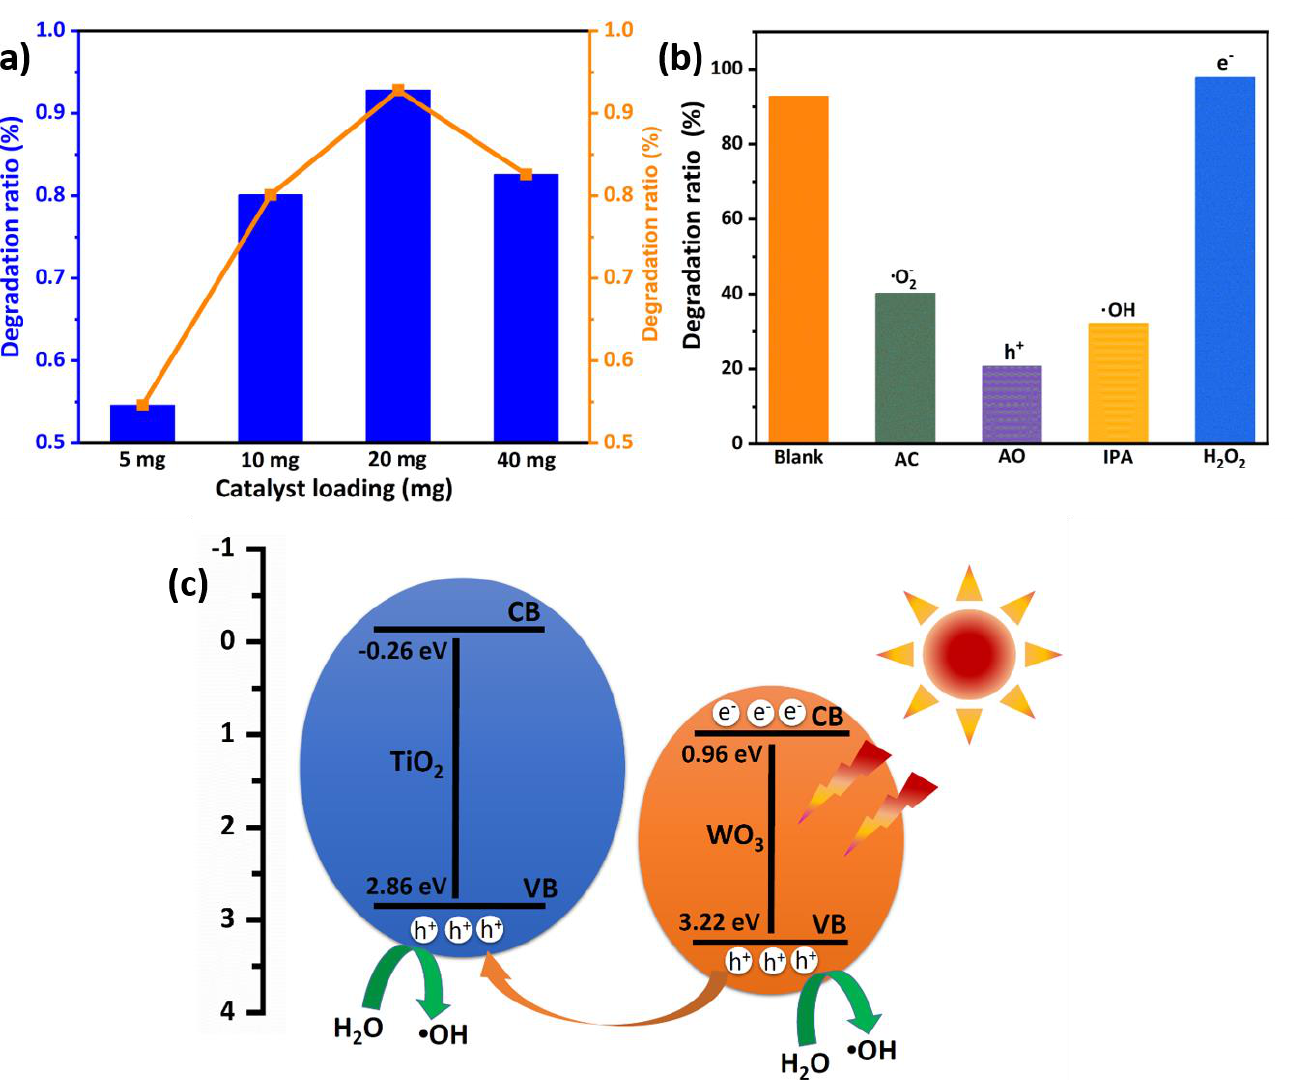
Figure 6. ( a ) The effect of WO 3 /TiO 2 − 25 catalyst loading on RhB photodegradation ratio. ( b ) Trap- ping test for active species during RhB photodegradation with the WO 3 /TiO 2 − 25 photocatalyst. ( c ) Proposed photocatalytic mechanism of WO 3 /TiO 2 photocatalyst.